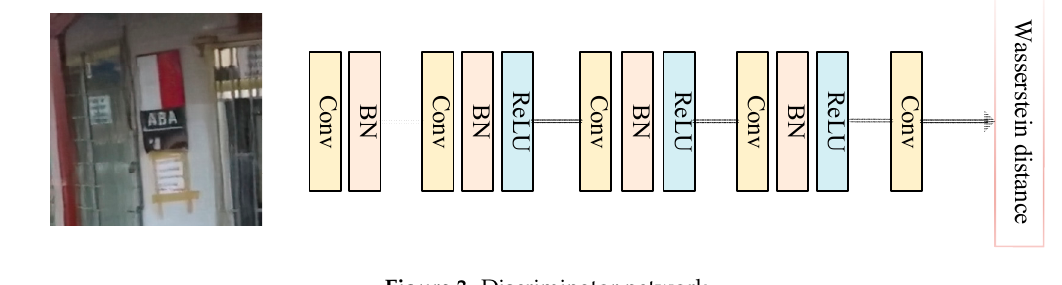
Figure 3. Discriminator network.